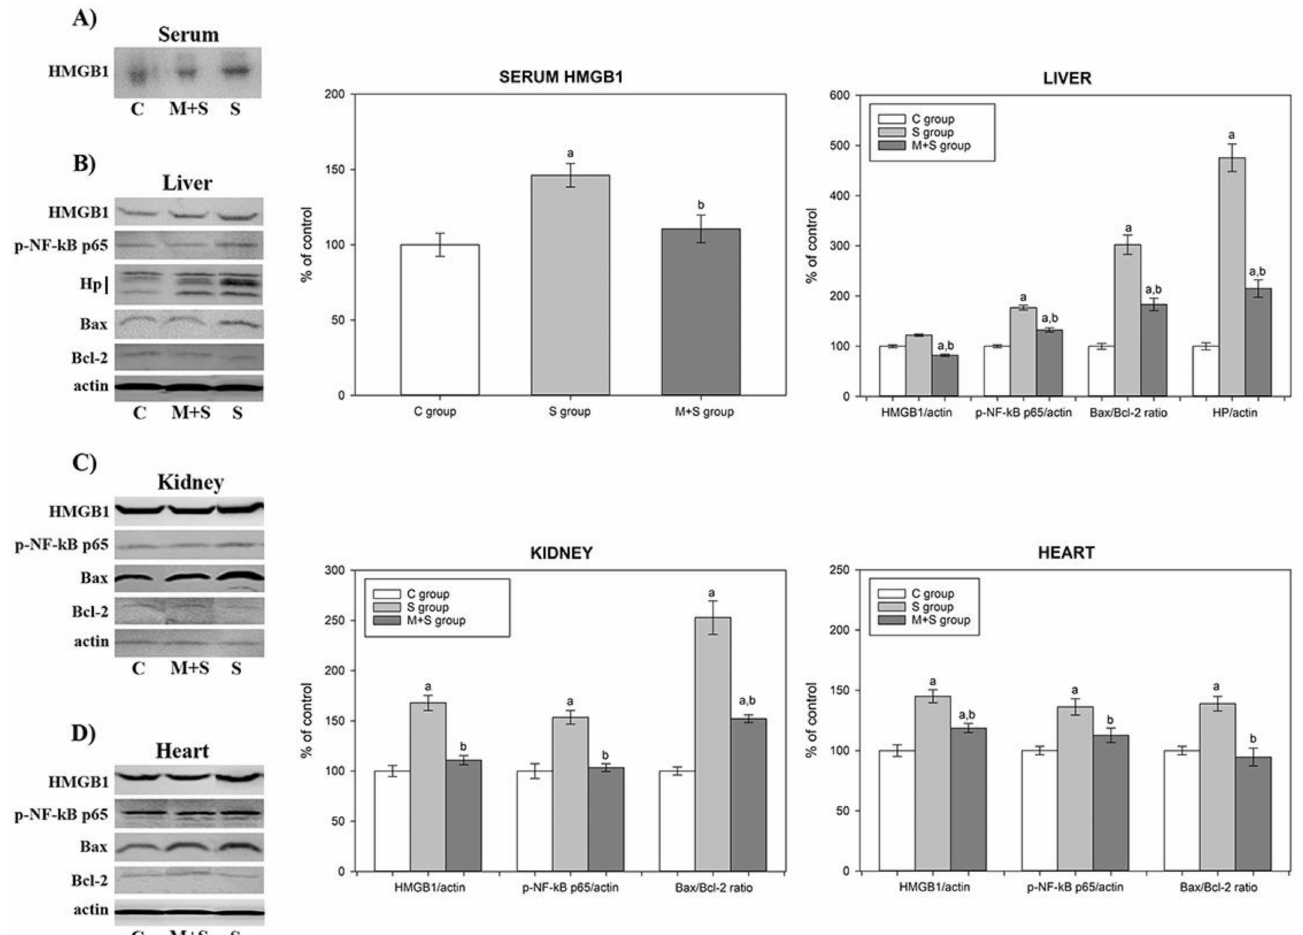
Figure 3. Representative immunoblots of protein expression levels: ( A ) serum HMGB1; ( B ) liver HMGB1, p-NF- κ B p65, Hp, Bax, and Bcl-2; ( C ) kidney HMGB1, p-NF- κ B p65, Bax, and Bcl-2; and ( D ) heart HMGB1, p-NF- κ B p65, Bax, and Bcl-2 in rats of control (C), sepsis (S), and meldonium + sepsis (M + S) groups. β actin was used as a loading control. Protein expression levels were calculated and graphically presented as the percent of control (mean ± standard error). Note: tissue samples were loaded on the gels in the groups order C, M + S, and S (blots presented on the left side of the figures), whereas calculated protein expression levels were graphically presented in the groups’ order C, S, and M + S (graphs presented on the right side of the figure). Minimal significance level: p < 0.05. Significantly different: a in respect to C; b in respect to